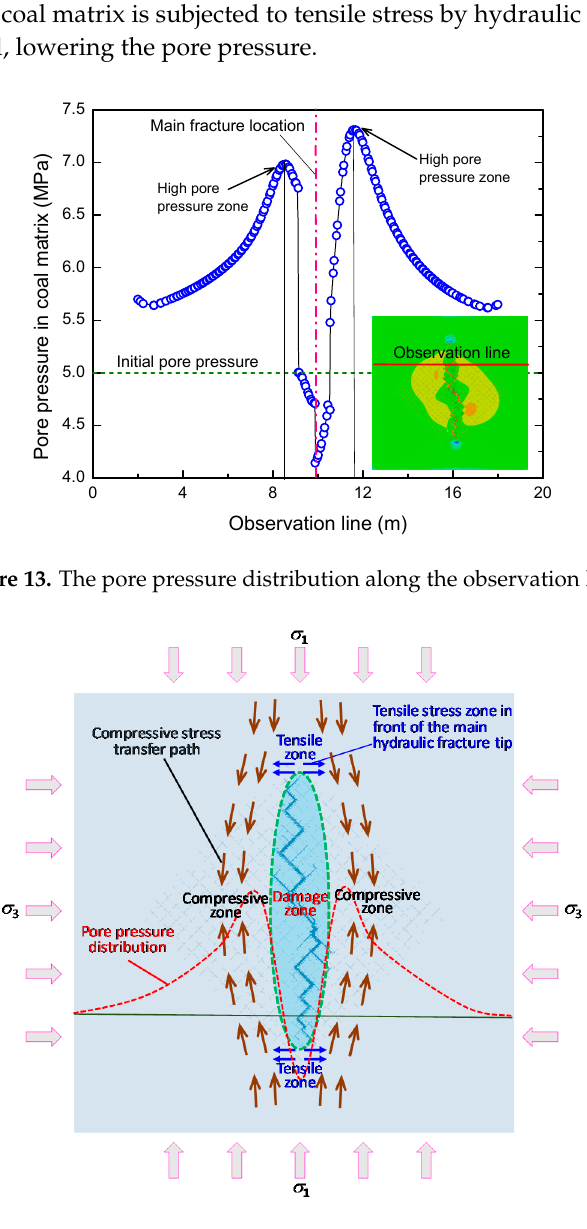
Figure 14. The schematic of pore pressure distribution around the hydraulic fractures.